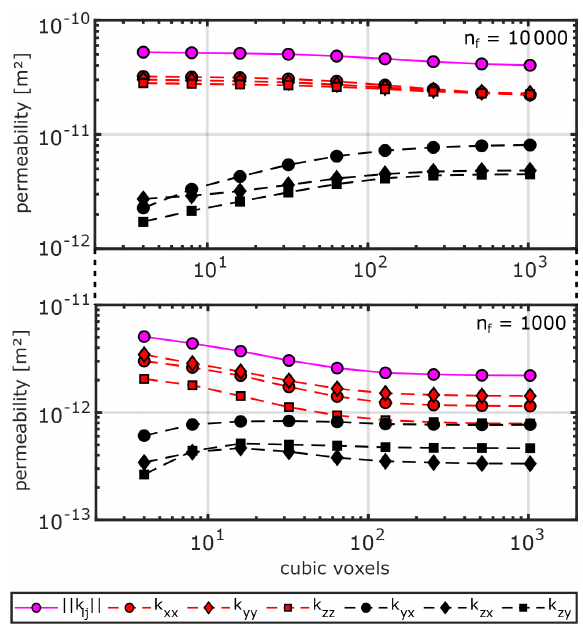
Figure 11. Absolute permeability values k for the six main compo- nents of the computed effective permeability tensor (principal com- ponents in red, off-diagonal components in black) and the norm of the permeability tensor in magenta as a function of the grid resolu- tion in cubic voxels (number of voxels in the x – y – z